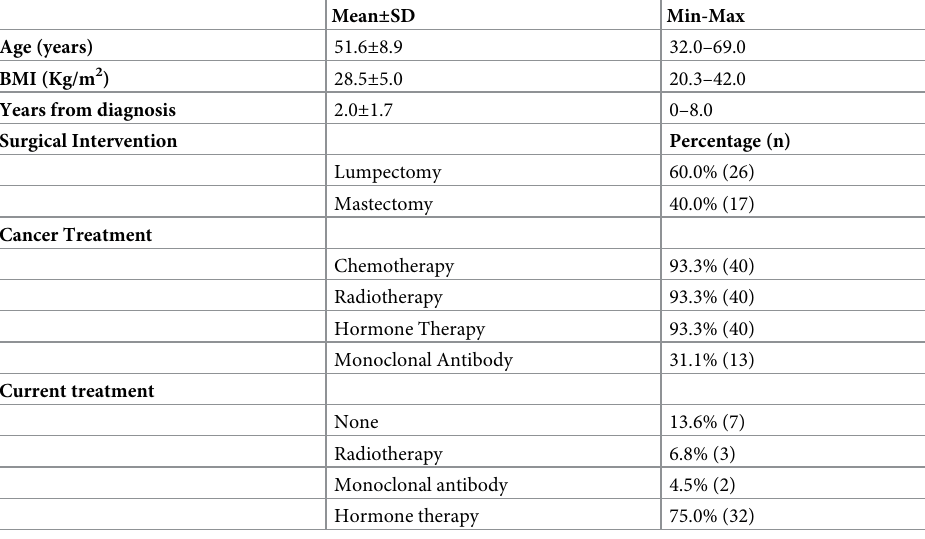
Table 1. Participant demographic and clinical